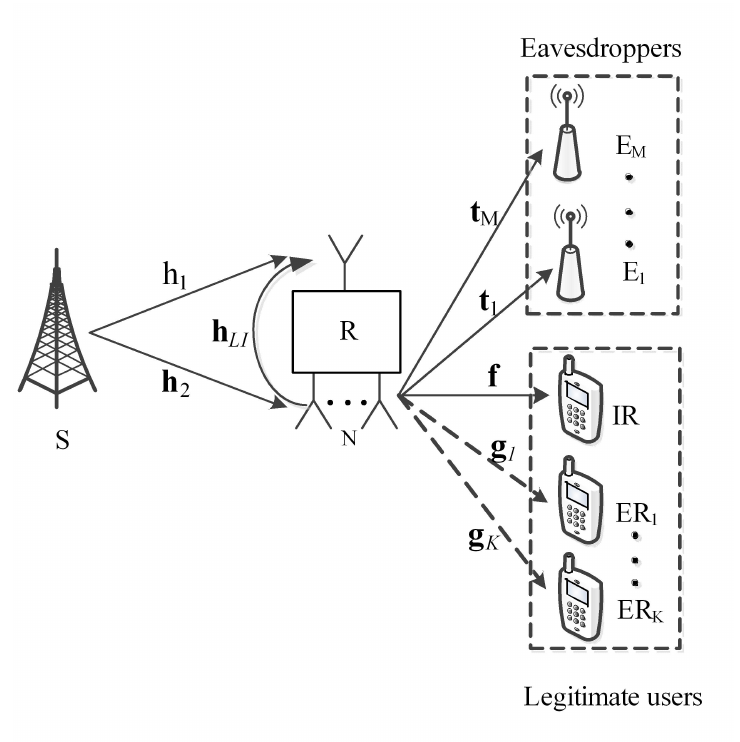
Figure 1. System model of FD-WPR network.